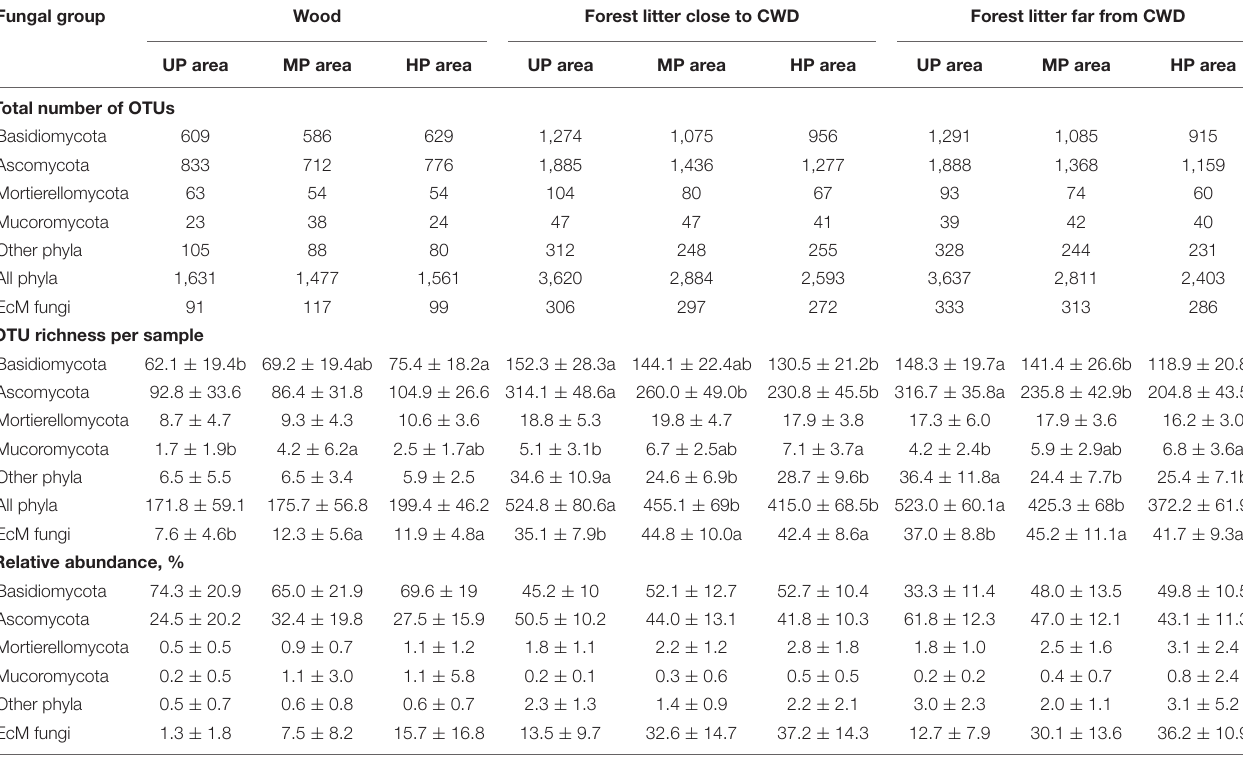
Mean ± SD are shown, n = 29 samples per area. Different letters depict a statistically significant difference of mean values between areas for a particular substrate revealed with Tukey’s test (p < 0.05). CWD, coarse woody